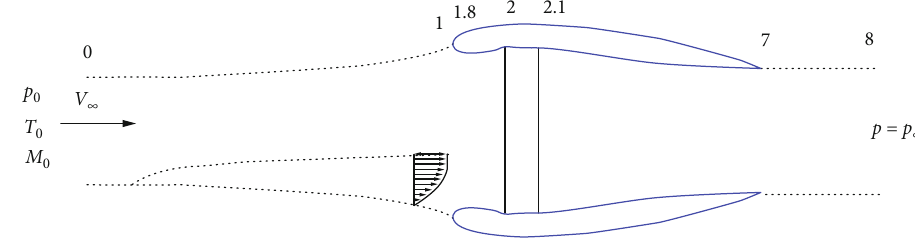
Figure 6: Station numbers of the discrete thermodynamic cycle analysis module.